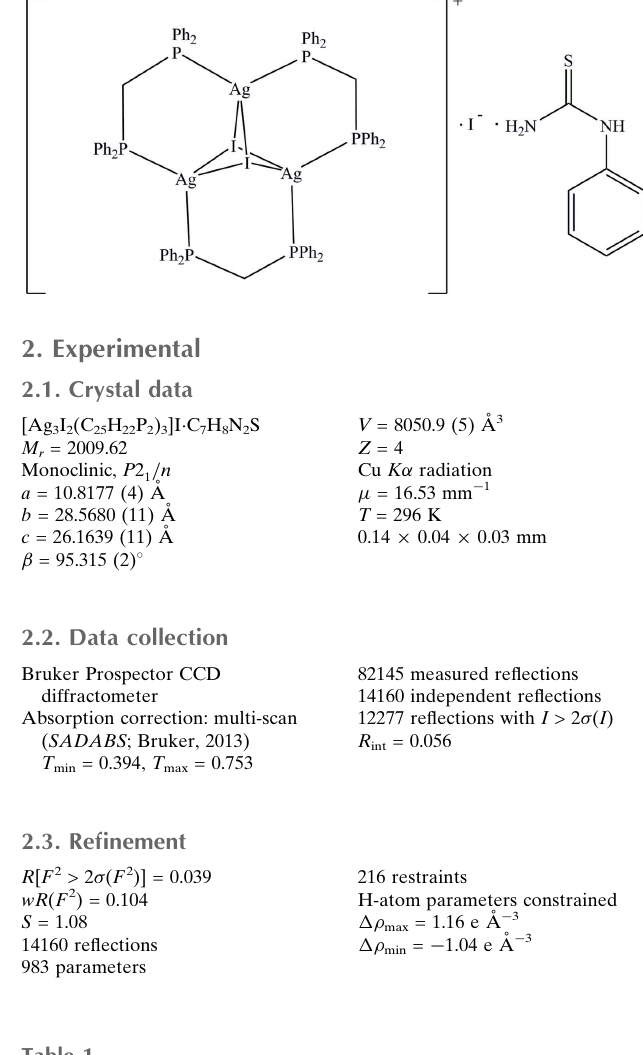
Hydrogen-bond geometry (A˚ , (cid:4)